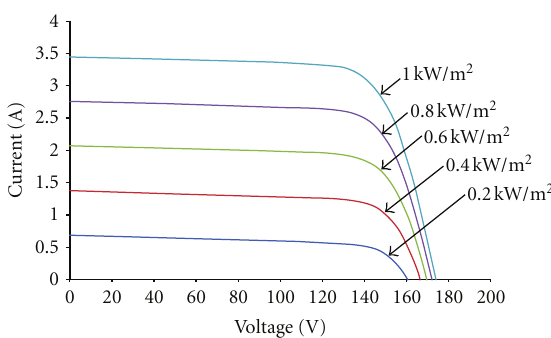
Figure 4: The I - V characteristic curve of solar cells under di ff erent sunlight intensity.